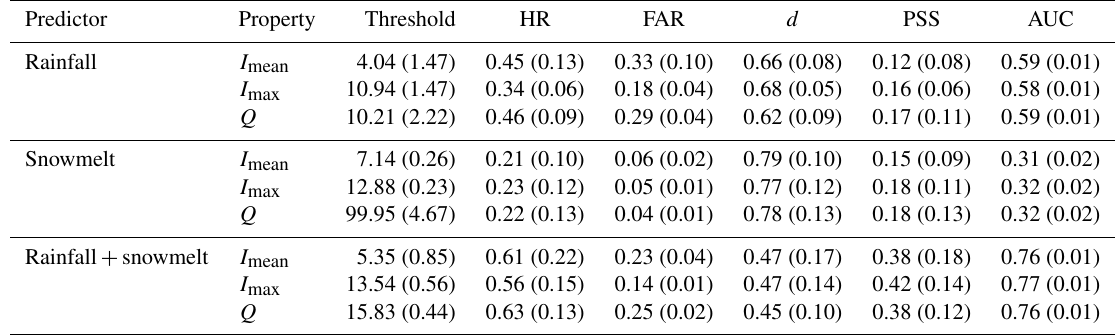
Table A3. K -fold validation results. Mean values and standard deviations (in parentheses) for thresholds of I mean (mmd − 1 ), I max (mmd − 1 ), and Q (mm) for UTL events of rainfall, snowmelt, and the sum of rainfall and snowmelt (rainfall + snowmelt), as well as corresponding performance